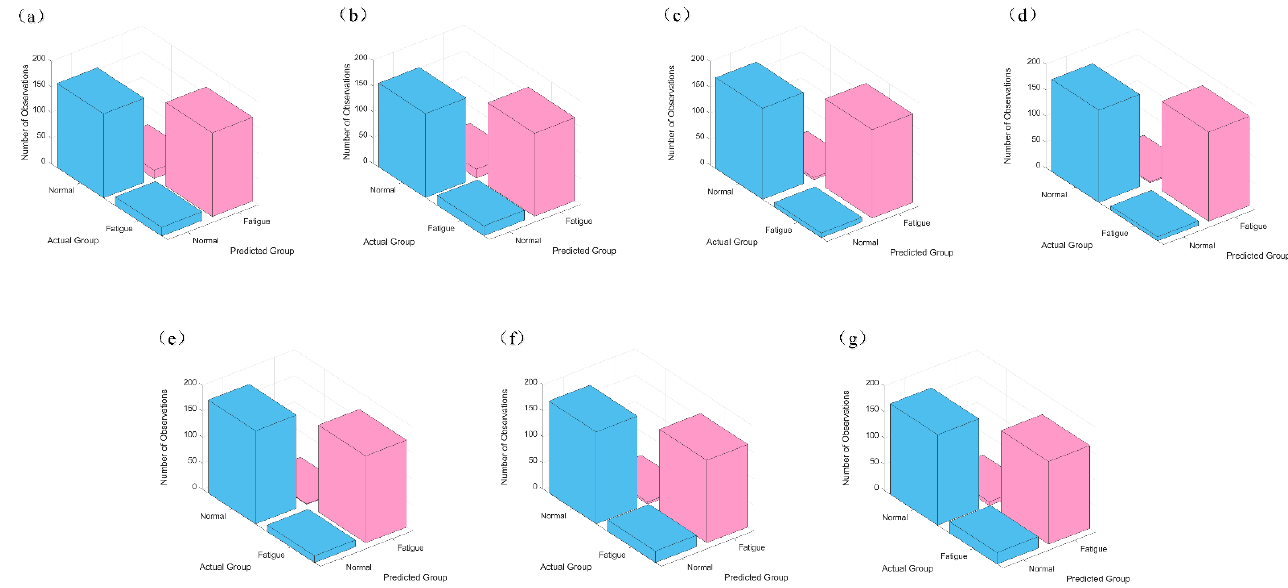
Figure 4. 3D confusion matrices for SampEn feature approach using multiple machine learning algorithms: ( a ) LR; ( b ) linear SVM; ( c ) quadratic SVM; ( d ) cubic SVM; ( e ) fine KNN; ( f ) medium KNN; ( g ) cubic KNN. Table 1. Performance analysis of the KNN, SVM, and LR machine learning algorithms on the testing dataset (The best performance result is indicated in bold).